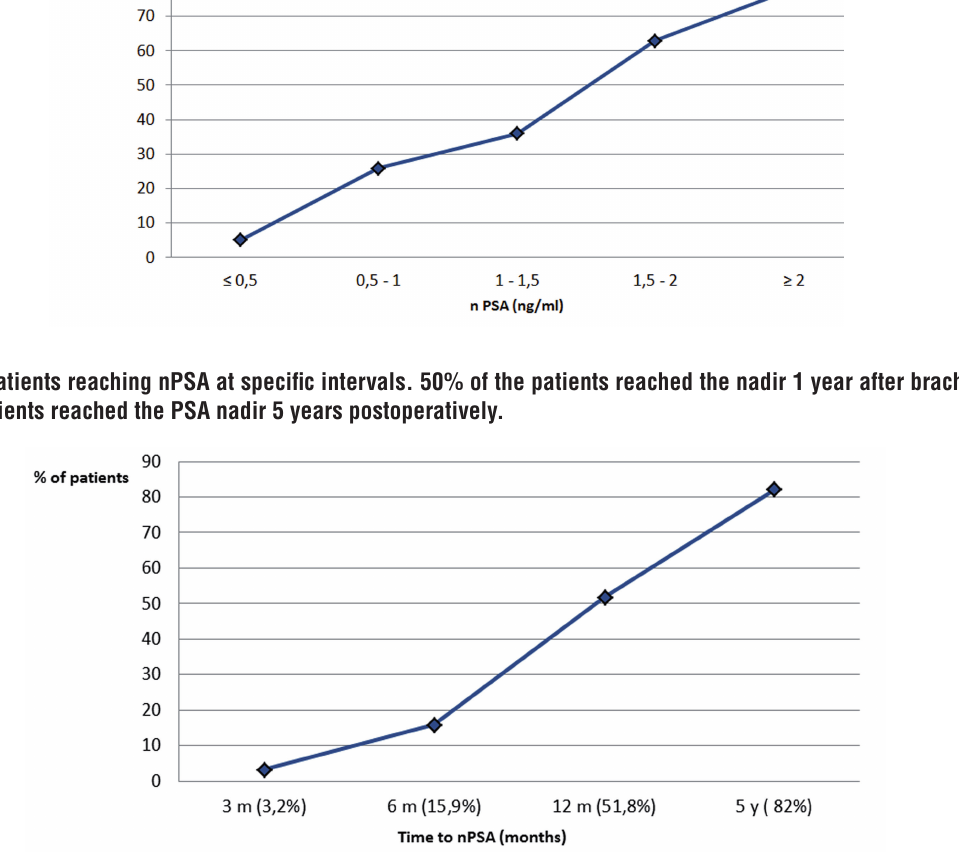
Figure 3 - Mean nPSA values in different patients measured at specific time interval. Reaching the PSA nadir fast does not necessarily mean that the treatment is more efficient. Patients with a slowly declining PSA tended to reach a lower PSA